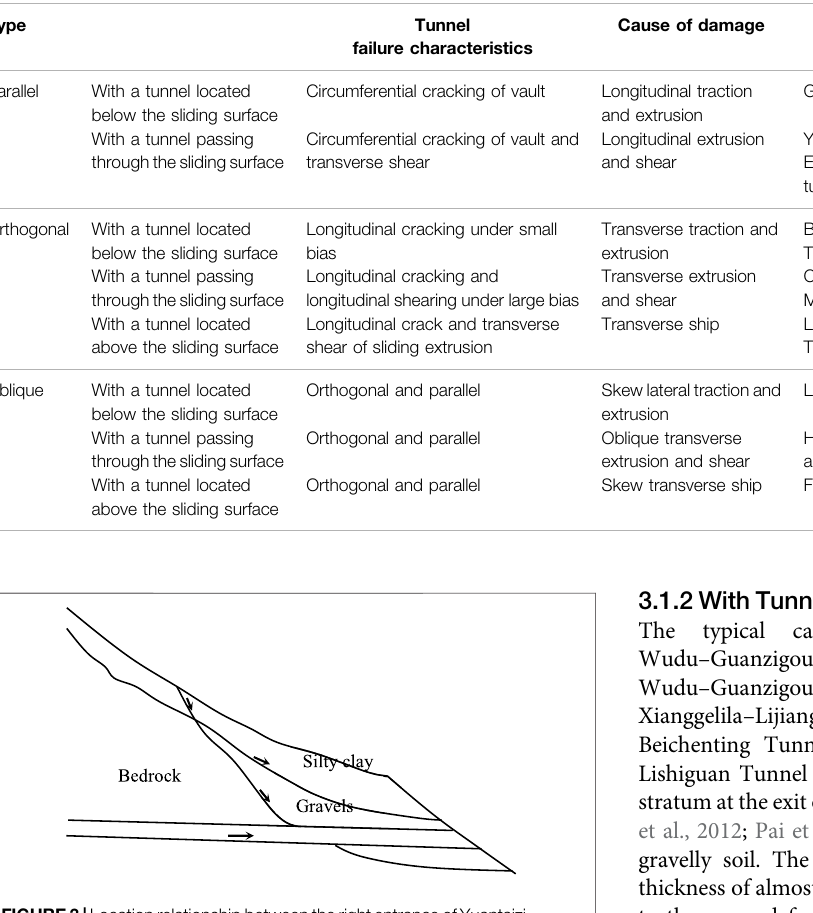
Frontiers in Earth Science |